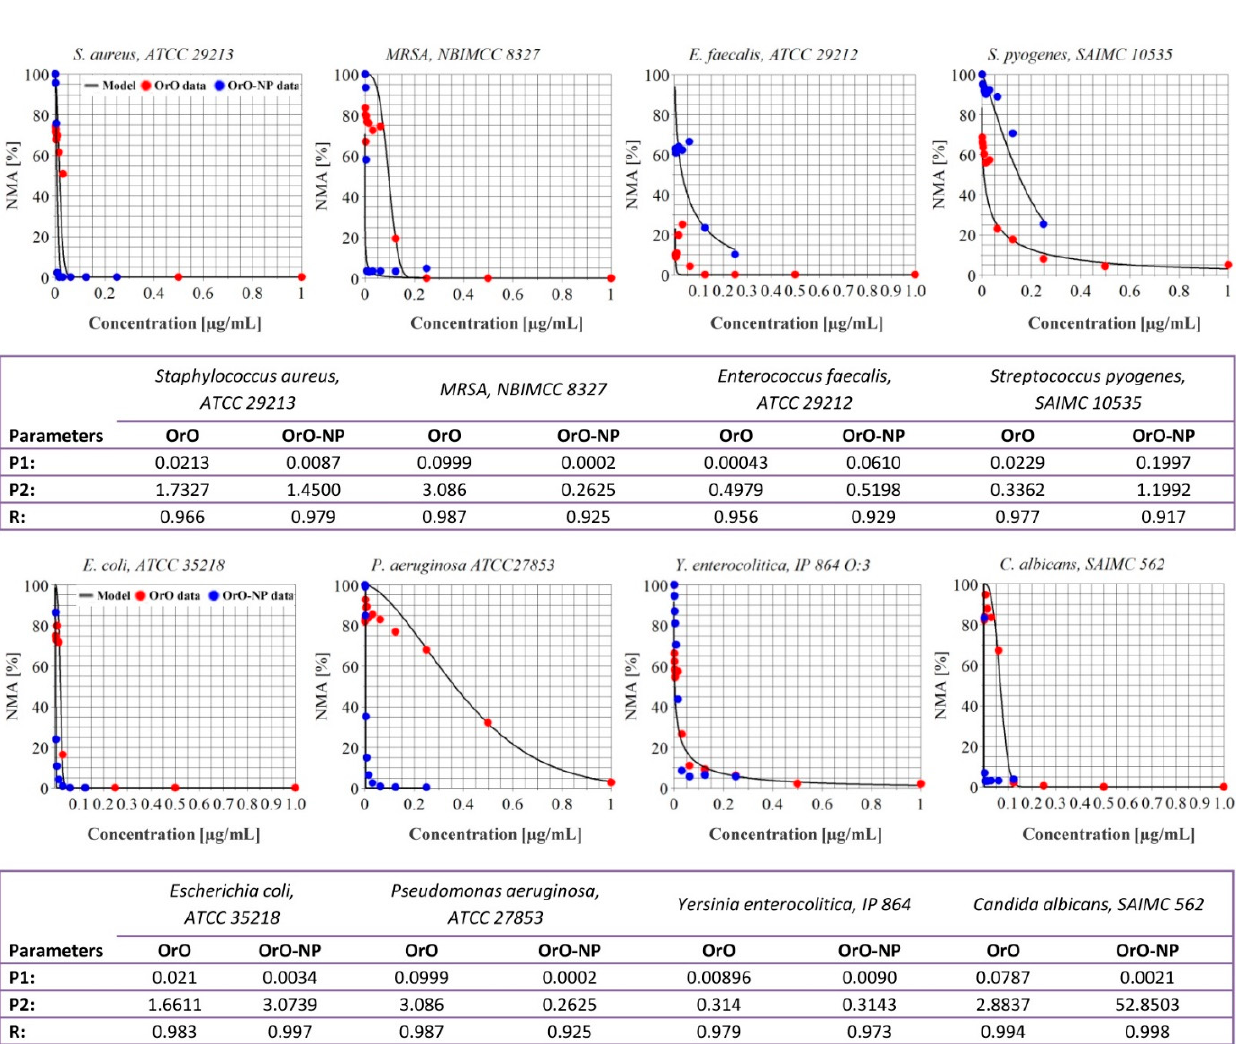
Figure 5 . Metabolic activity of the bacterial strains treated with oregano oil — comparison between pure oil and the nanoformulation based on chitosan and alginate. Legend: OrO = Origanum vulgare oil, OrO ‐ NP = Origanum vulgare oil encapsulated in a chitosan nanodelivery system, P1 = coefficient of inhibition in the Lambert–Pearson model; P2 = hill slope (by realization of the model); R = correlation coefficient showing the descriptive power of the model for the specific experimental data; NMA = normalized metabolic activity.